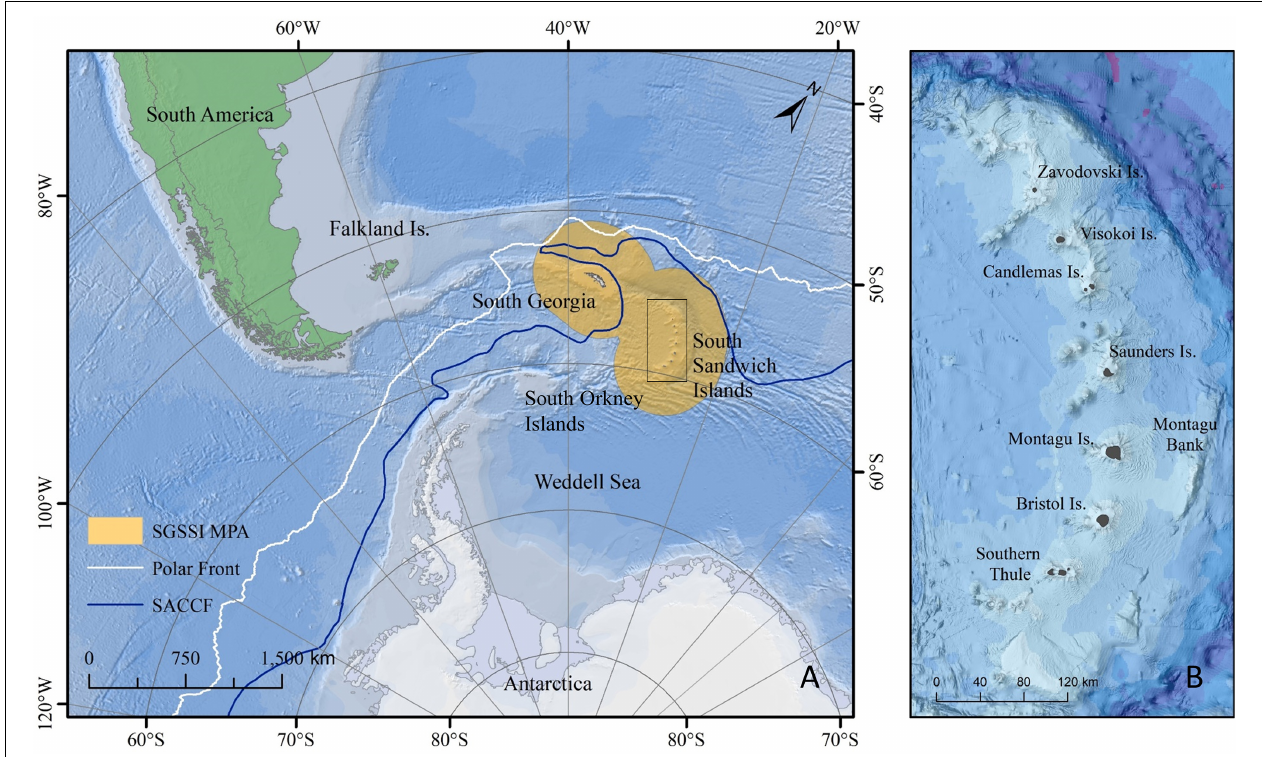
FIGURE 1 | (A) The geographical and oceanographic setting of South Georgia and South Sandwich Islands marine protected area (SGSSI MPA) (orange polygon) relative to the Polar Front (white line) and the Southern Antarctic Circumpolar Current Front (SACCF) (blue line). (B) The geographical setting of the South Sandwich Islands archipelago using bathymetry data from Leat et al. (2016), classified using 1,000 m depth contours.